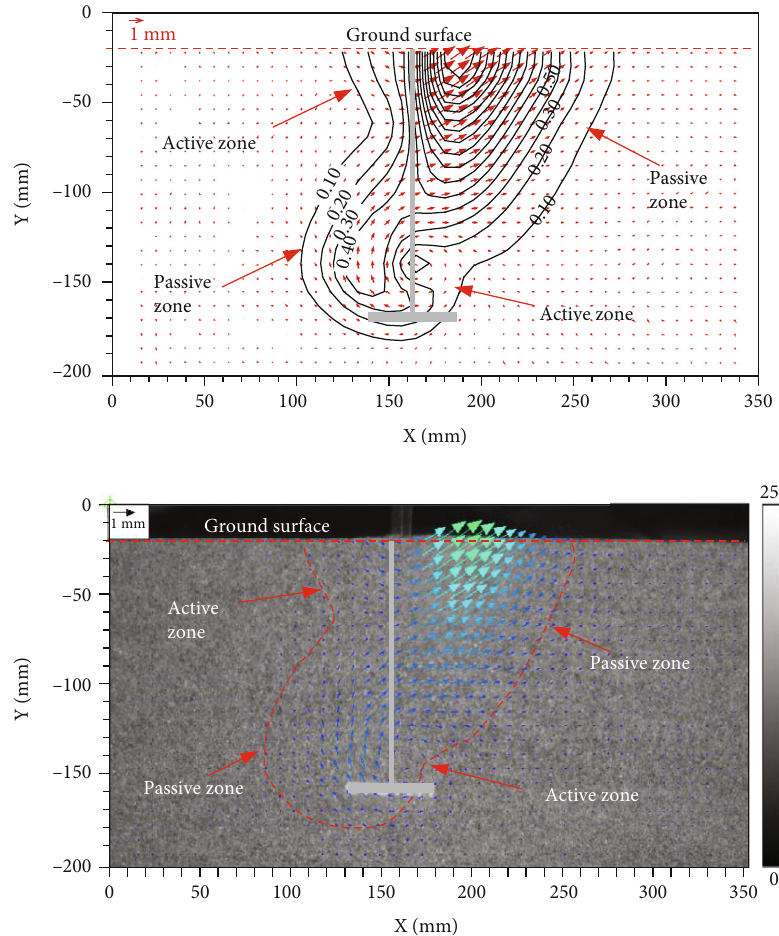
Figure 8: Displacement fi eld at the ultimate load for D